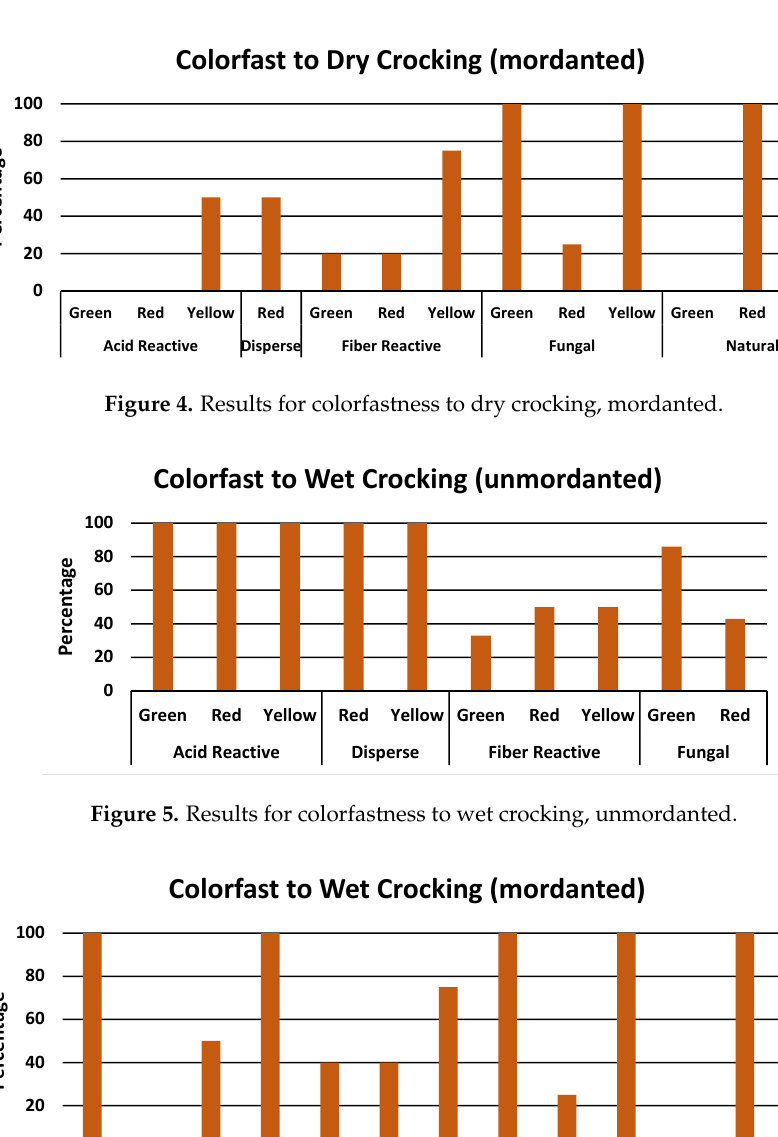
Figure 3. Results for colorfastness to dry crocking, unmordanted. Coatings 2016 , 6 , 25